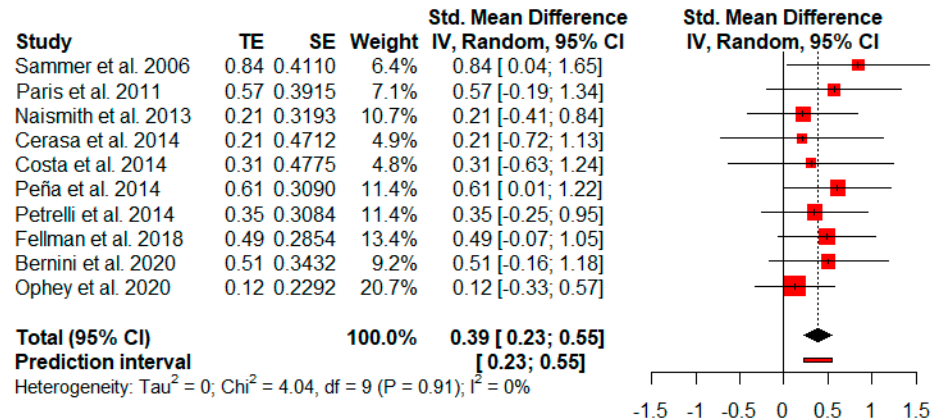
Figure 2 . Effectiveness of cognitive rehabilitation in overall cognitive functions.